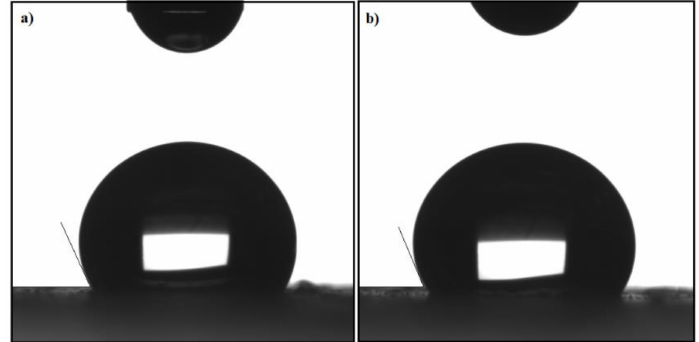
Figure 7. Contact angles of ( a ) DA-MNPs and ( b )